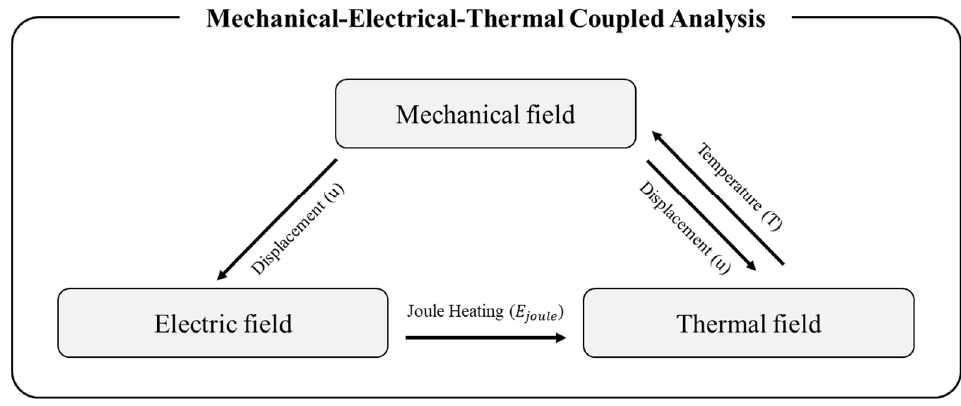
Figure 2. Concept of mechanical–electrical–thermal coupled analysis. The finite element model of the LIB cell was constructed using the representative- sandwich (RS) model [8,9]. The RS model consists of a pouch cell composed of about 165 layers with 5 representative layers (positive current collector, positive electrode, separa- tor, negative electrode, negative current collector) and has mechanical properties similar to the full model using all 165 layers. In addition, it is possible to accurately predict an internal short circuit due to failure of the separator. Figure 3a shows the finite element model used for numerical analysis. The indenter is a rigid body, and the 1/4 model was used in consideration of symmetry.